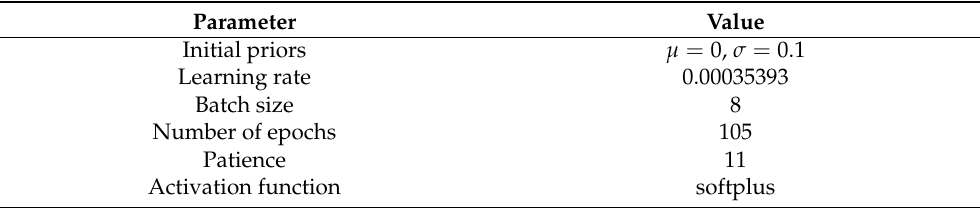
Table 2. Optimised Hyper-Parameters for